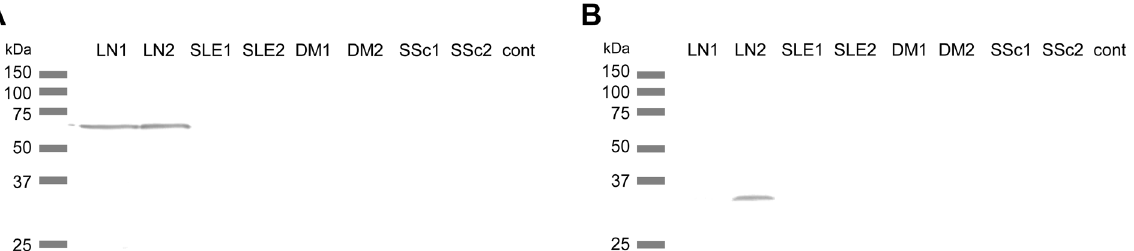
Fig 1. Immunoprecipitation of RRP8 and TNP1 with sera from patients with rheumatic diseases. Reprisentative photographs are shown. (A) RRP8 (50.7 kDa) (B) TNP1 (GST-tagged, 32.4 kDa). LN; active lupus nephritis, SLE; systemic lupus erythematosus without active lupus nephritis, DM; dermatomyositis, SSc; systemic sclerosis, cont; healthy